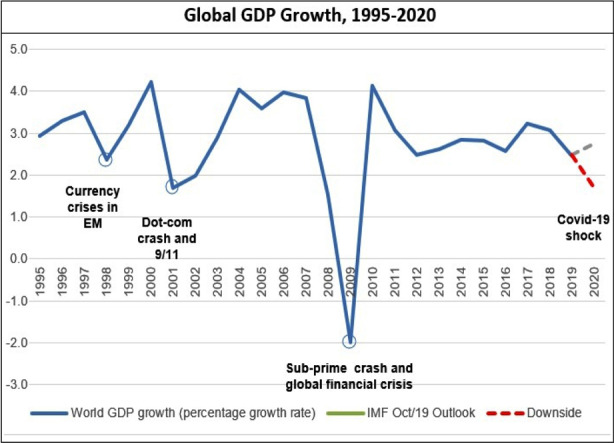
Global GDP growth, 1995-2020.22